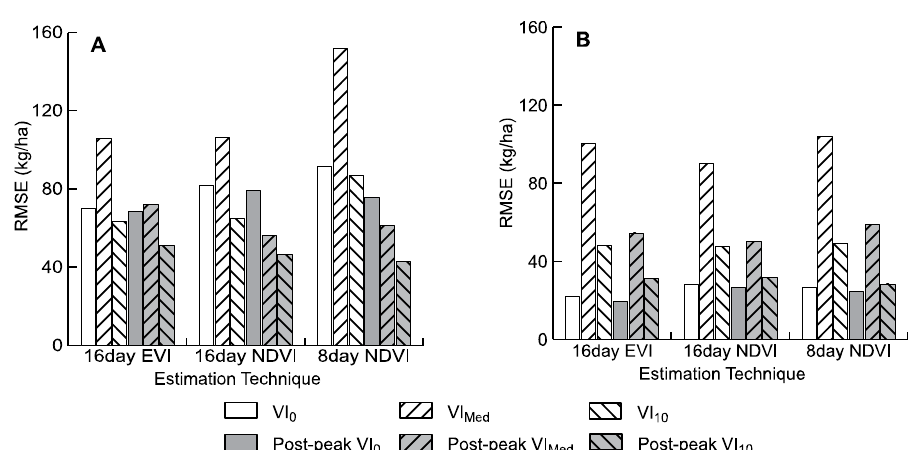
Figure 3. RMSE values are shown for the 18 models tested using ( A ) all study areas and ( B ) excluding the Agua Fria study area. Data are grouped by VI data type, and within each data type the techniques are ordered such that the first three bars in each group (white) indicate methods without adjusting for post-peak data collection, and the next three (gray) indicate models after adjusting for post-peak collection dates. N = 51.